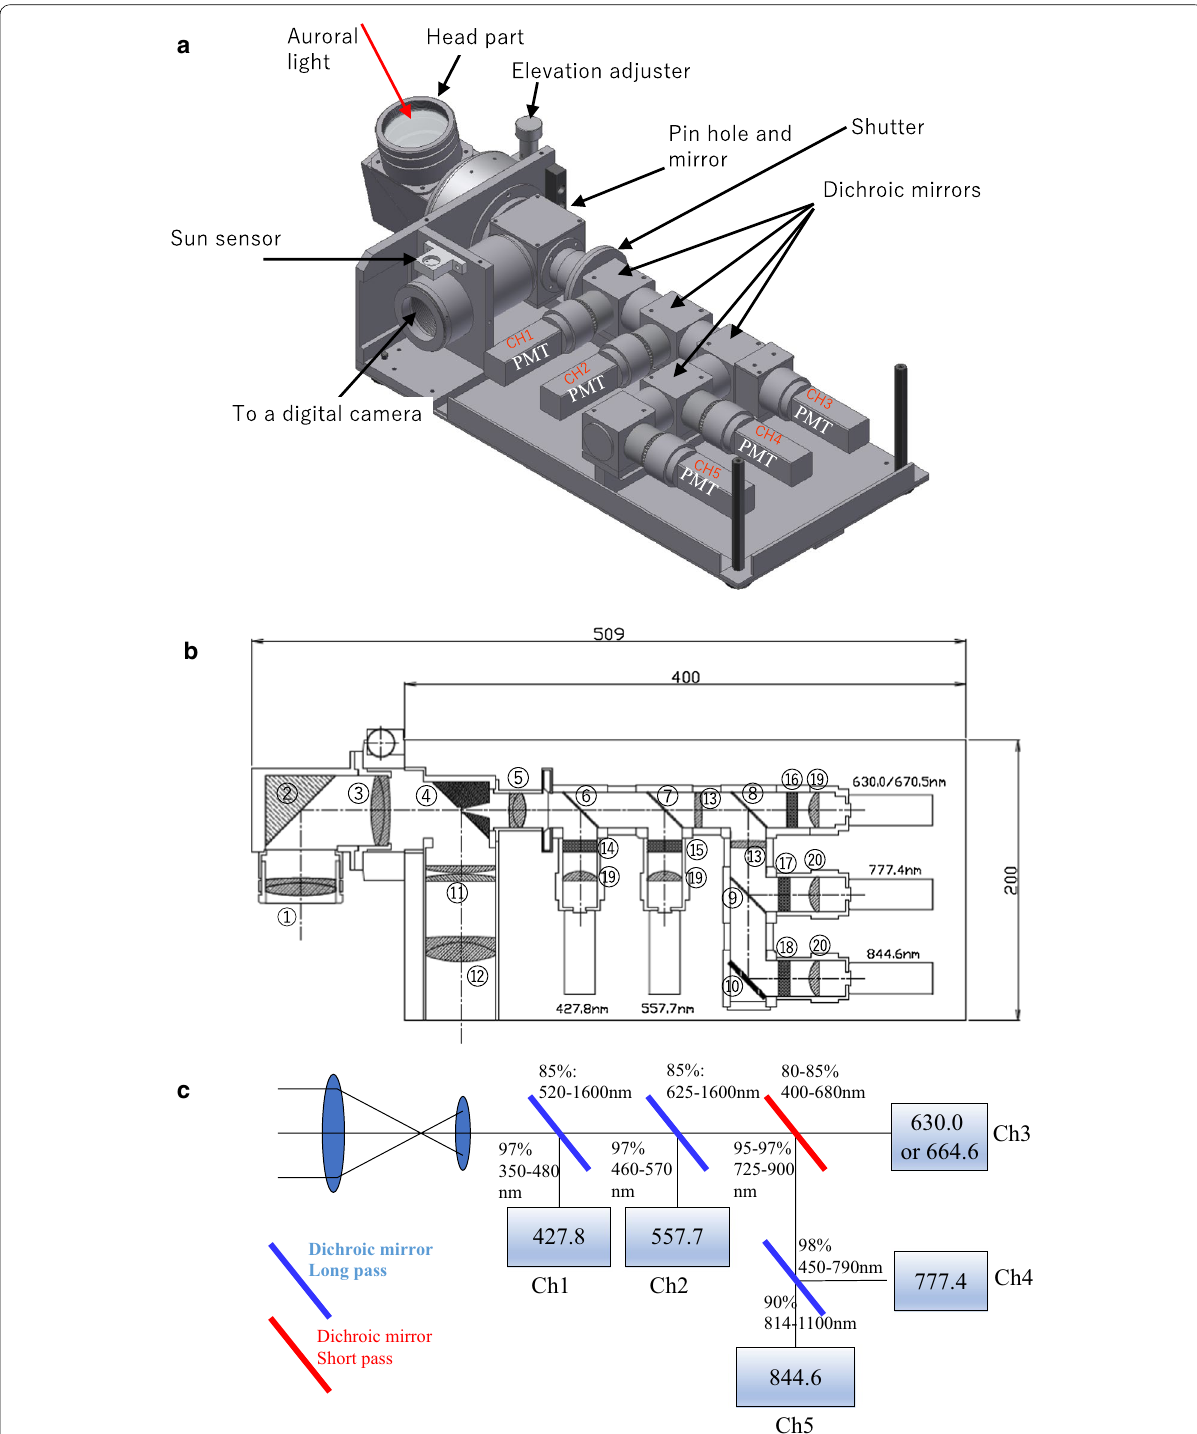
Fig. 1 a Schematic diagram of the optical unit of the photometer. b Block diagram of the optical part of the photometer. Unit is in mm. c Schematic diagram of distribution of the dichroic mirrors of the photometer. Penetration and reflection efficiencies of the dichroic mirrors with corresponding wavelength intervals are